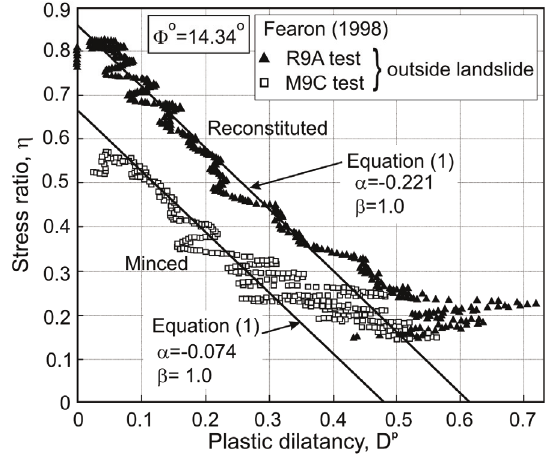
Fig. 11. Stress ratio-plastic dilatancy relationships for minced and reconstituted samples from the outside of the Acquara-Vadoncello